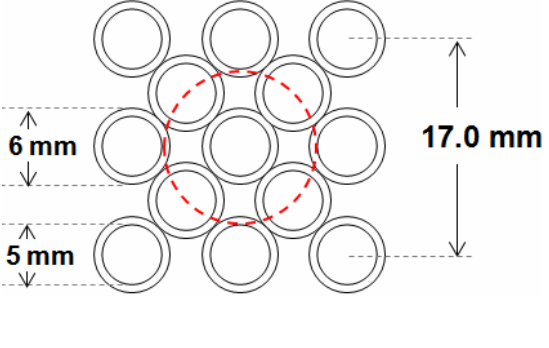
Figure 3. The spatial arrangement of two-dimensional LED panel that contains 13 LEDs: one coaxial LED at the center surrounded with 12 eccentric LEDs. The red dashed line indicates the location of the projected entrance pupil of the